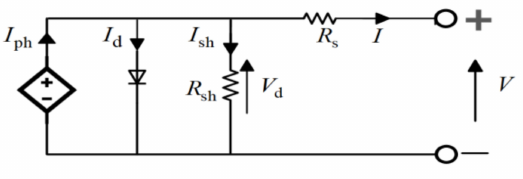
Figure 2. The single-diode model of a photovoltaic (PV)